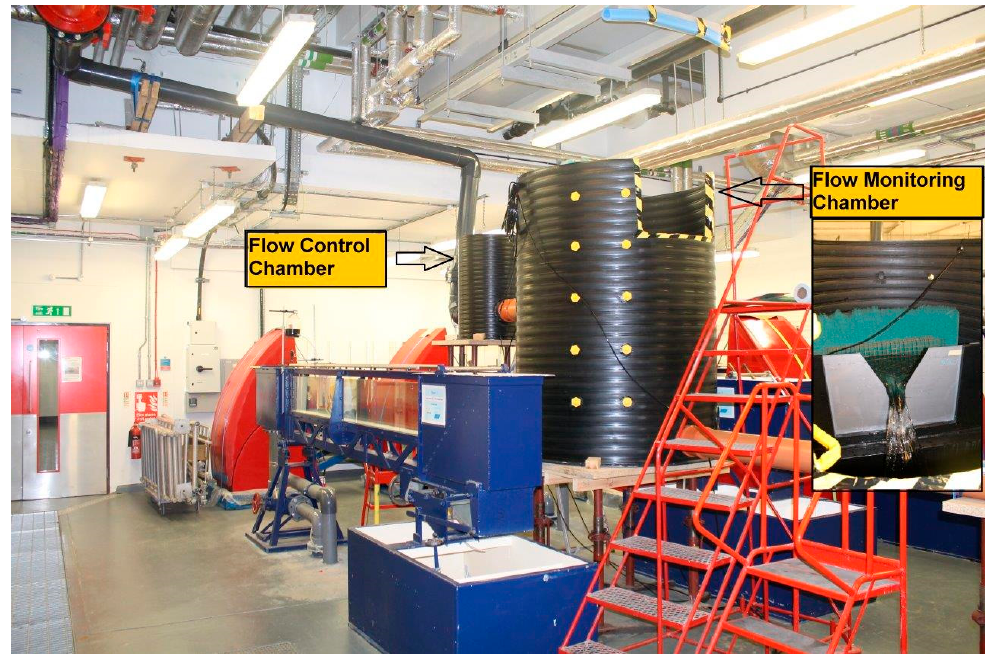
Figure 2. Calibration rig set-up for V-notch measurement of Green Infrastructure (GI) performance.